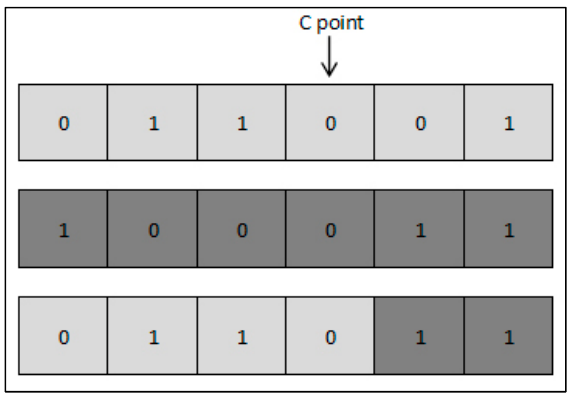
Figure 4. Crossover example using chromosomes of length L = 6.